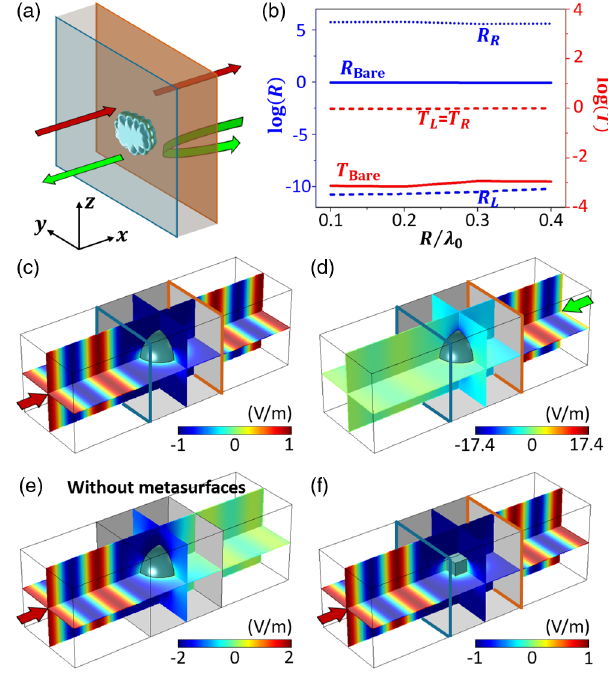
FIG. 4. (a) Illustration of the PT -symmetric metasurfaces separated by an ENZ medium slab embedded with an arbitrary three-dimensional object. (b) Reflectance and transmittance for an embedded dielectric sphere of ε d ¼ 4 under the left (dashed lines) and right (dotted lines) incidence. (c) – (f) Distribution of E z in the ENZ medium slab for (c,f) the case with PT -symmetric metasurfaces for left incidence, (d) the case with PT -symmetric metasurfaces for right incidence, and (e) the case without PT -symmetric metasurfaces. The impurity is as